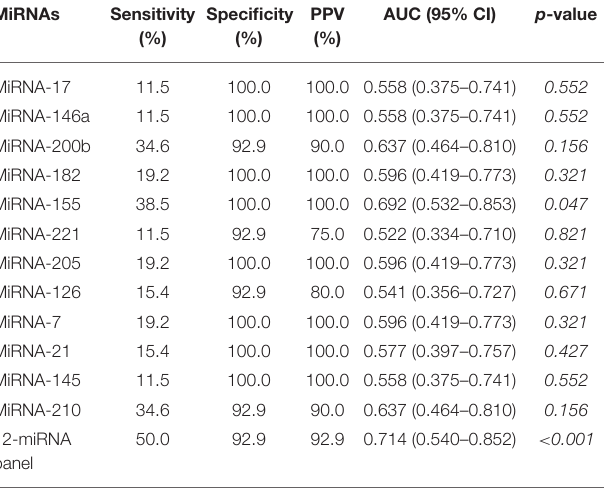
TABLE 4 | Sensitivity, specificity, positive predictive value, and area under the curve of the 12 miRNAs in the validation group.